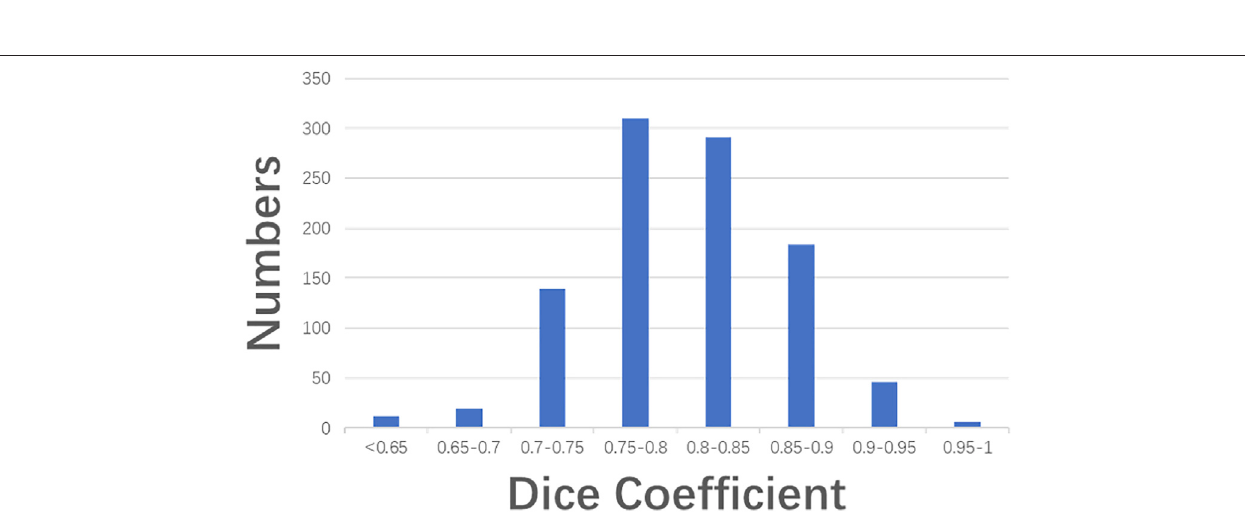
Frontiers in Bioengineering and Biotechnology |